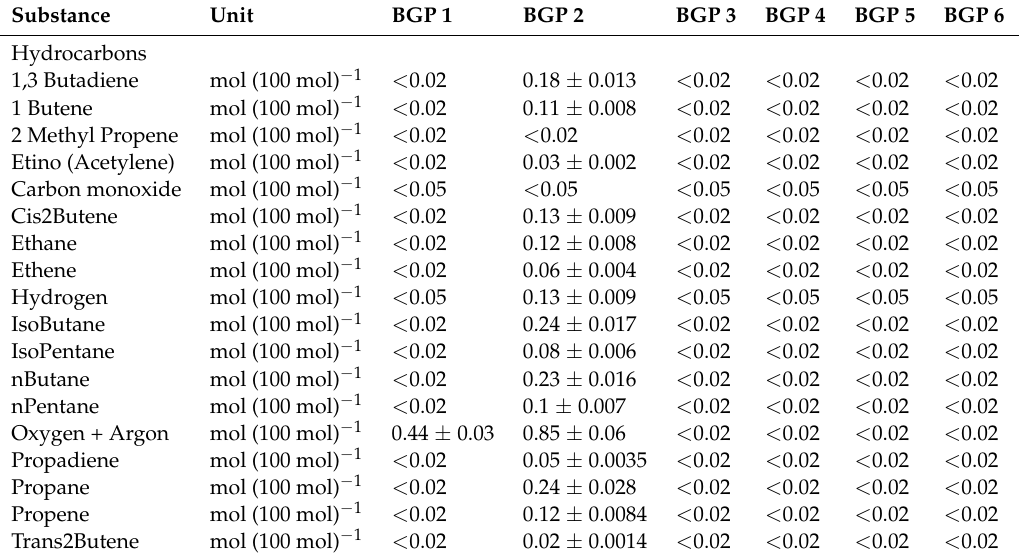
Table 10. Biogas composition—part